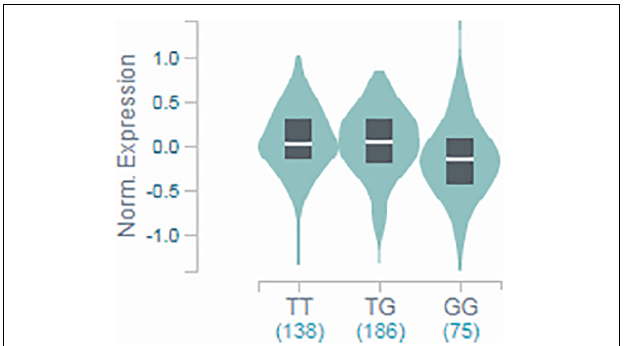
FIGURE 1 | GTEx portal data showing the association of rs4804416 on INSR expression in thyroid tissue. Normalized expression in tissue with T/T genotype was 0.017, in T/G was 0.036, and G/G was –0.146 ( T -test statistic = –3.0, P =